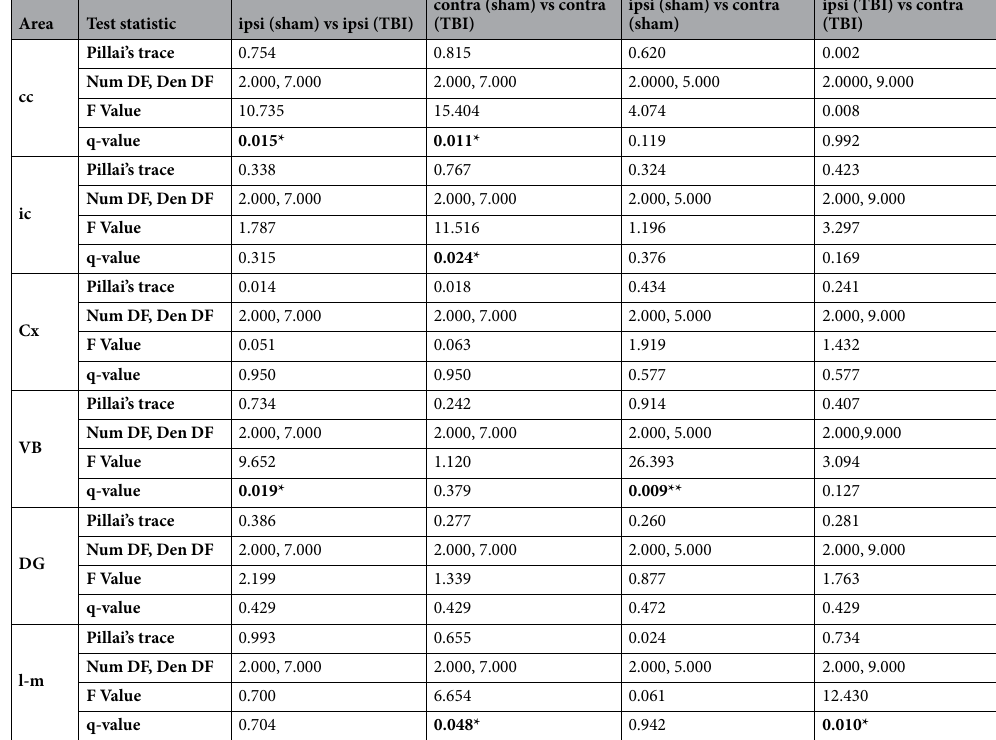
Table 1. MANOVA of the isometric log-ratio transformed 3-tissue signal fractions ( ilr 1 , ilr 2 ). Bold text indicates statistically significant differences: * q (ilr1, ilr2) < 0.05, ** q (irl1, ilr2) < 0.01. Abbreviations: cc,